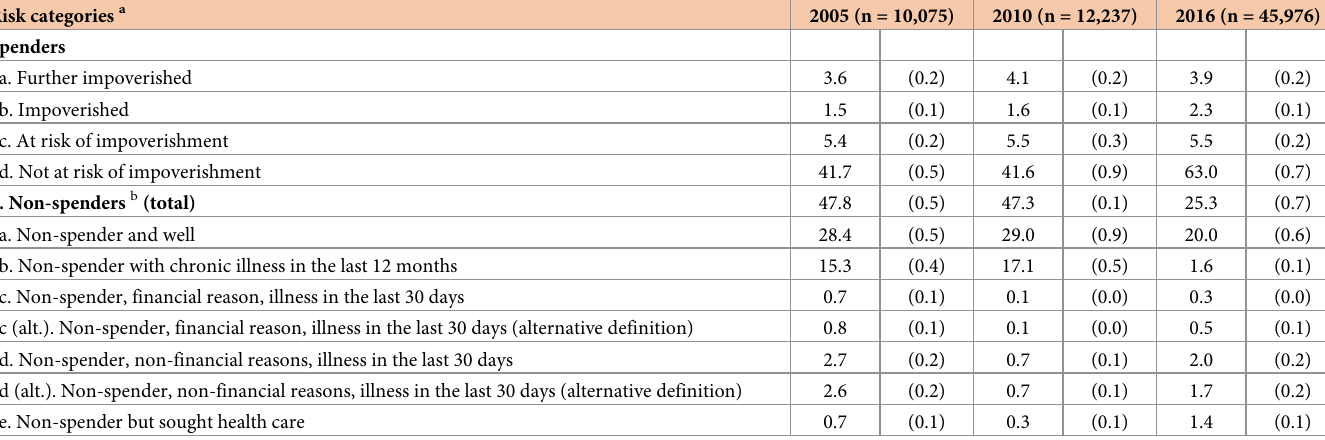
Table 2. Incidences of impoverishment effects and non-spenders (including households forgoing care due to financial reasons) (as % of all households). Risk categories